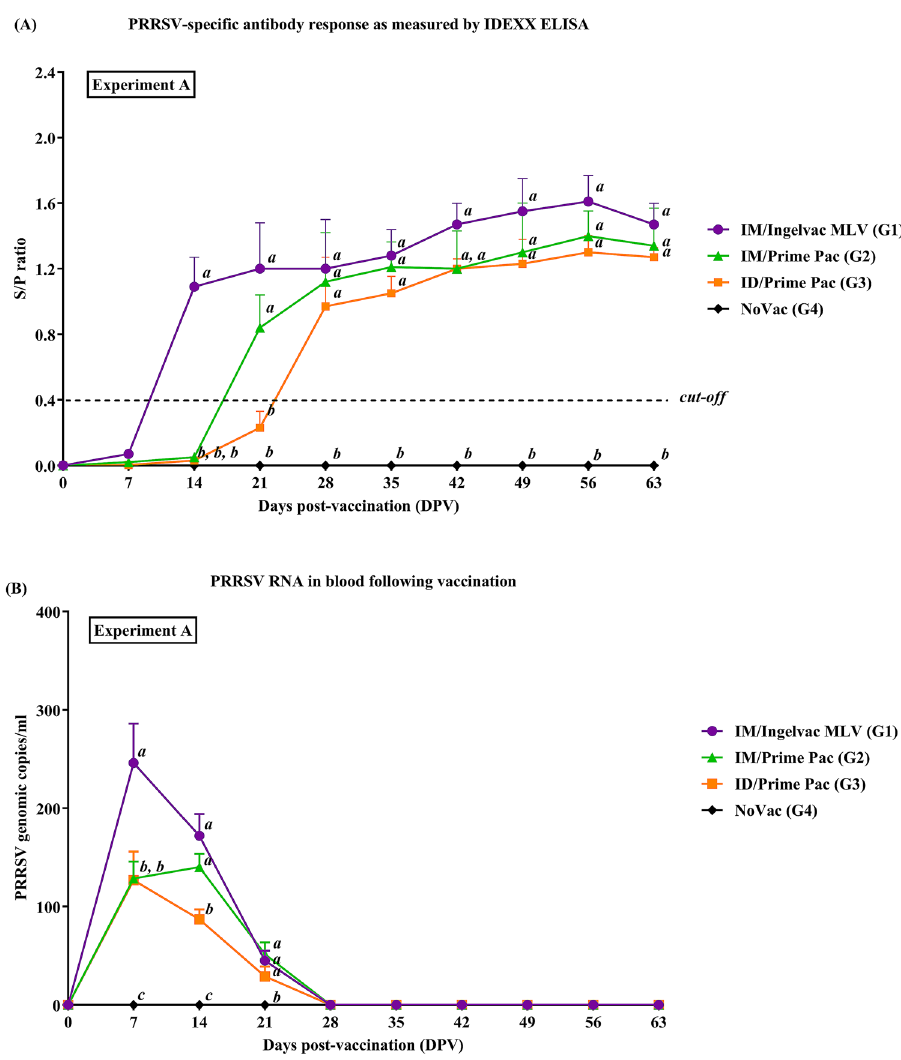
Figure 1. Mean values of ( A ) PRRSV-specific antibodies as measured by ELISA and ( B ) genomic copies of PRRSV RNA in the blood of pigs in Exp A. Values expressed as mean ± SEM. ( A ) Sample-to-positive (S/P) ratios equal to or greater than 0.4 were considered positive (cut-off value, dashed-line). The results were compared using two-way ANOVA for multiple comparisons. Different lowercase letters ( a – c ) indicate significant differences between treatment groups ( P < 0.05) for each